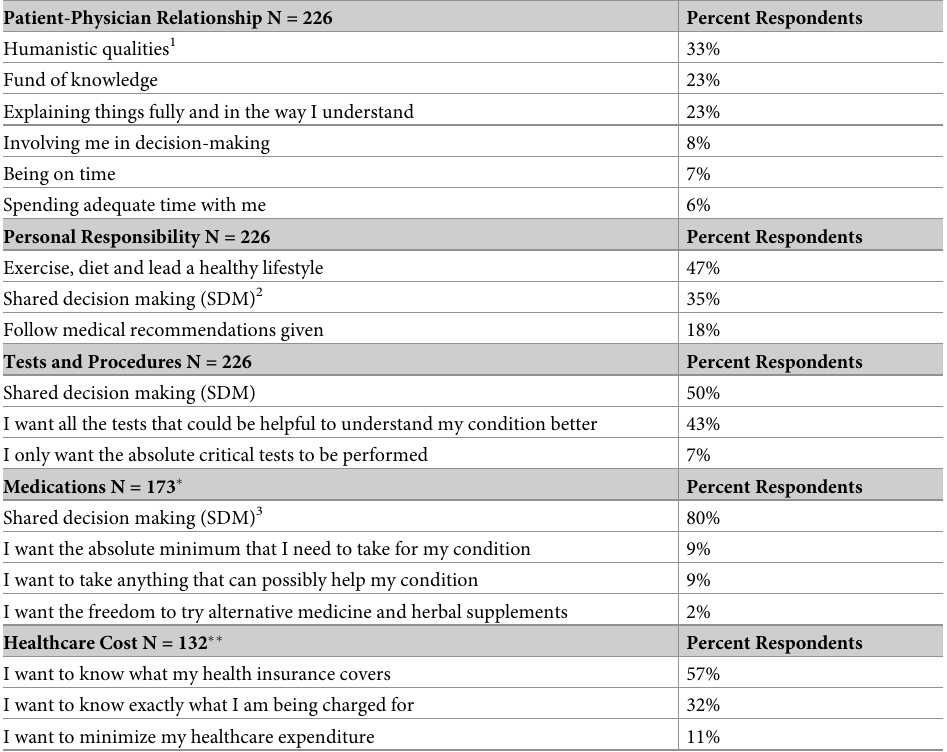
Table 2. The percentage of respondents who selected each quality as top